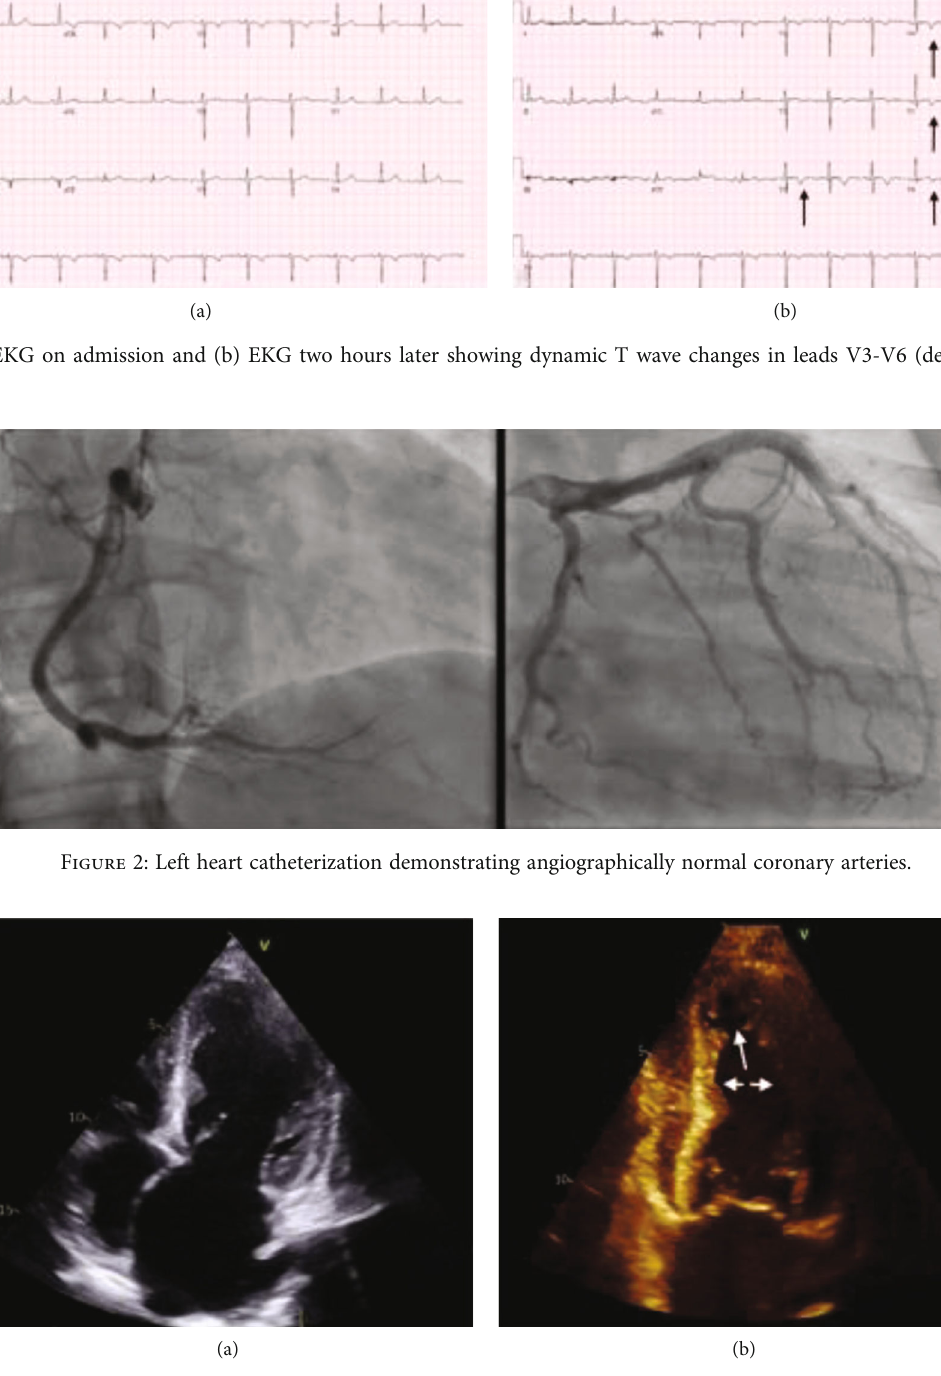
Figure 3: Transthoracic echocardiogram four-chamber view (diastolic image on (a), systolic image on (b)) demonstrating classic pattern of apical akinesis and hypercontractility of midbasal segments of the LV (arrows on (b) emphasizing this speci fi c pattern of wall motion abnormalities seen in Takotsubo ’